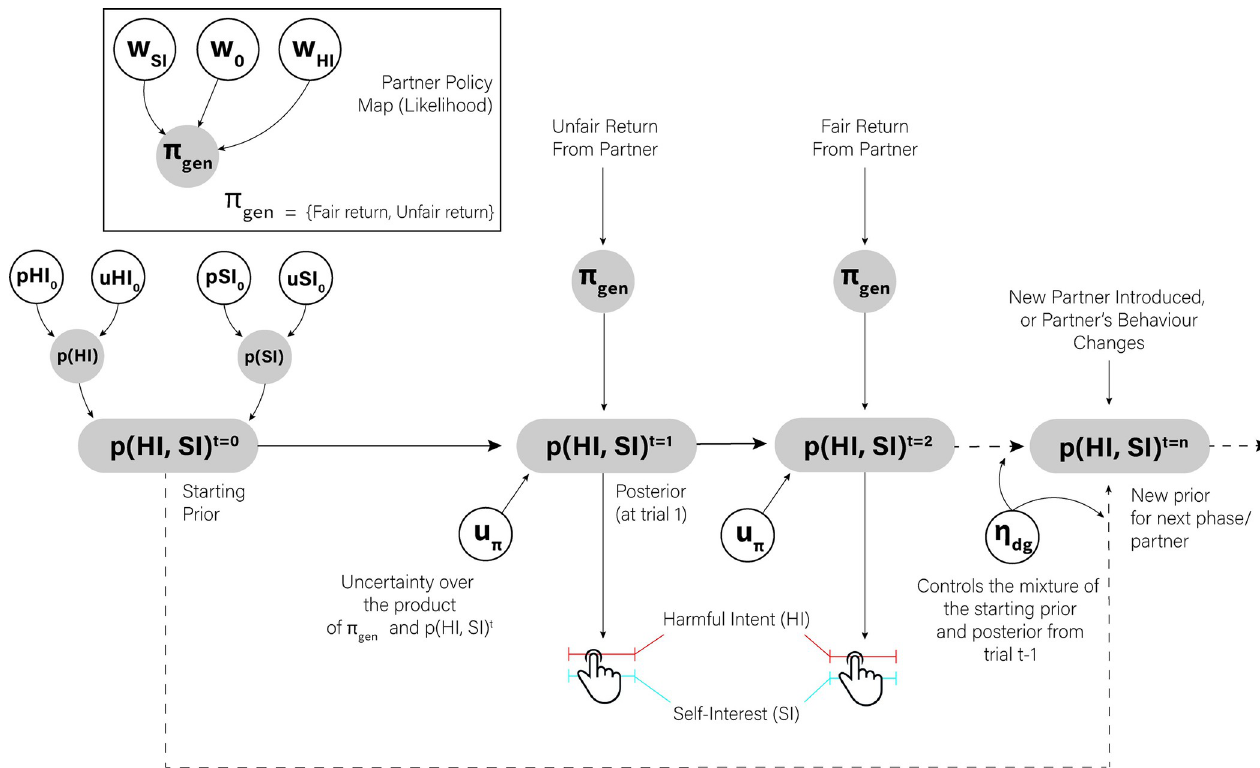
Fig 2. Extended belief-based social attribution model schematic. White nodes represent free parameters of the model. Grey shaded nodes represent numerical probability matrices built from free parameters. Thick solid and thick dotted lines represent transitions between trials. Thin solid lines represent the causal influence of a node on another node or variable. The agent or participant updates their initial beliefs (starting prior) about the partner’s intentions (p(HI, SI) t = 0 ) each trial using their policy matrix of the partner ( π gen ) which maps the likelihood between a partner’s return to the participant and the partner’s true intentions weighted by three free parameters: a policy-map intercept (w 0 ), sensitivity to update self-interest attributions (w SI ), and sensitivity to update harmful intent attributions (w HI ). The integration between the likelihood and prior belief from the previous trial is also subject to another free parameter, uncertainty over partner policies (u π ). We assume that upon detecting a change (in this task, a reversal), participants re-set their beliefs, using their priors about people in general (thin dotted line), biased by what they have learnt already about their present partner (reset-at-reversal— η dg ). Both the policy matrix and initial beliefs about the partner are numerical matrices that assigned probabilities to each grid point of values of harmful intent (0–1) and self-interest (0–1). The model can be used to simulate observed attributions of intent given a series of returns, or inverted to infer the parameter values for participants, using experimentally observed